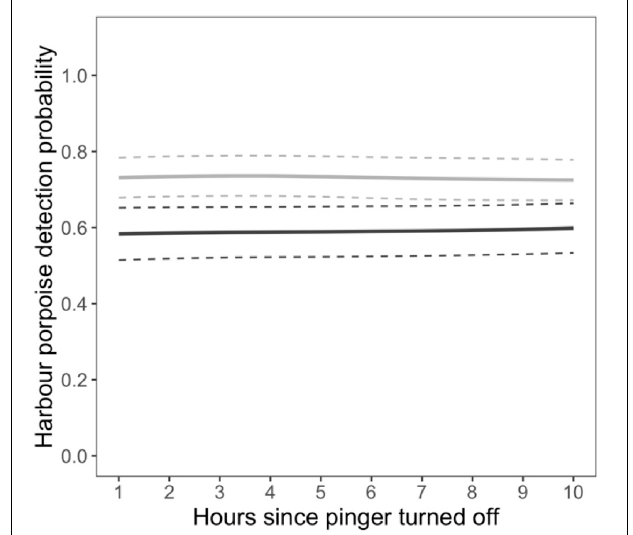
FIGURE 4 | Displacement. Relationship between the probability of detecting harbour porpoises and the number of hours since the pinger turned off as a function harbour porpoise presence 1 h before the pinger turned on (absent: dark gray, present: light gray) at the C-POD near the pinger. Lines denote predictions from the top ranked model presented in Table 1 . Standard errors are shown by the colored dashed lines.